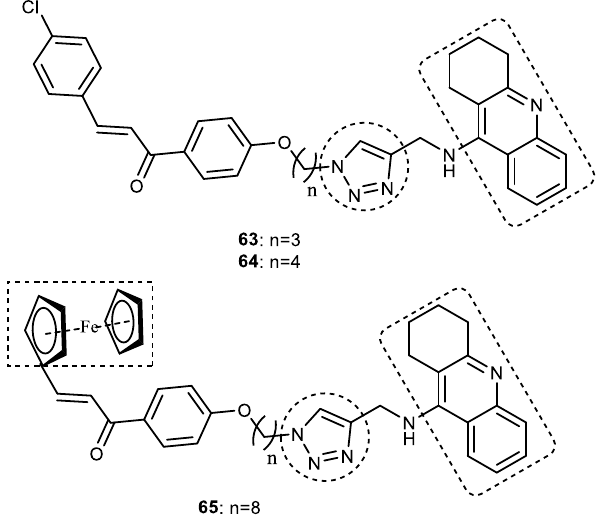
Figure 20. Chemical structure of tacrine – 1,2,3-triazole – chalcone